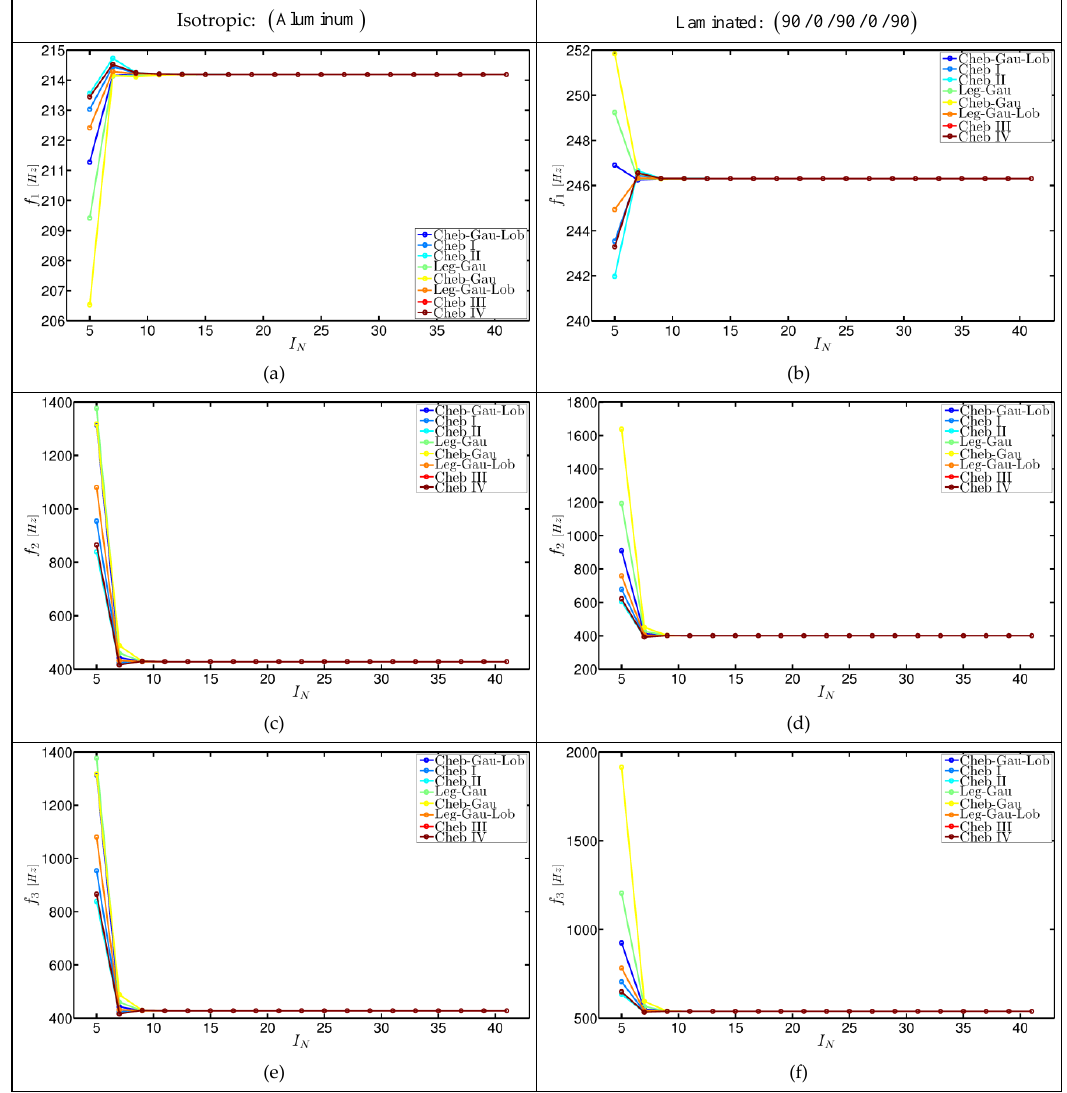
Figure 3. Convergence characteristics of the first three frequencies for a completely clamped (CCCC) square plate ( L x = L y = 2m) of thickness h = 0.1m for two different lamination schemes as a function of the number of grid points I N = I M , varying the grid distribution. The ELW theory is the ELD1 χ in both the circumstances. (a) and (b) are related to the first frequency, (c) and (d) to the second one and (e) and (f) to the third one.